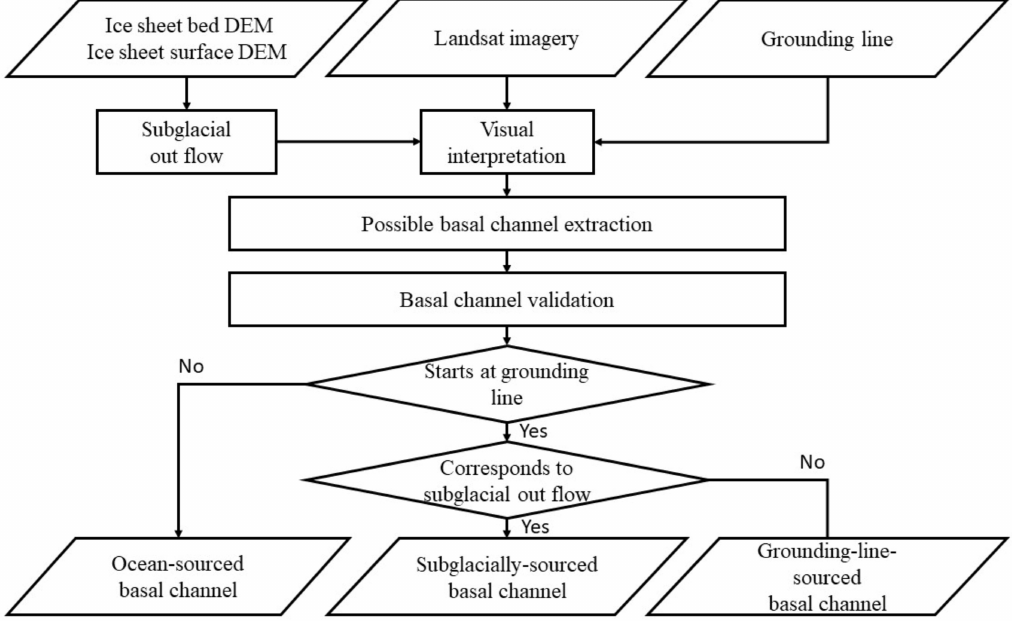
Figure 5. Basal channel extraction